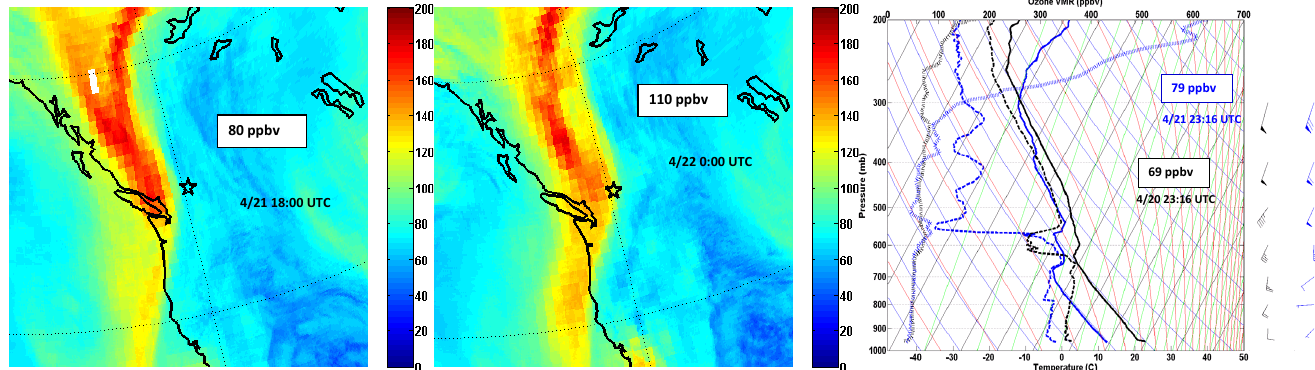
Fig. 5. MUTOP versus the Kelowna, BC ozonesonde launch on 21 April 2006. The two zoomed MUTOP images from (a) 21 April at 18:00UTC and (b) 22 April at 00:00UTC show the rapid increase of the UT ozone over six hours associated with the advancement of the dry-air streamer. The color bars represent layer-average UT ozone VMR inppbv and the black stars mark the location of Kelowna, BC, where the MUTOP estimated value is shown in the box for each time. (c) The Skew-T Log-P diagram presents vertical profiles of ozone, temperature, dewpoint temperature, and column winds for the previous day, 20 April (gray crosses, black line, black dash line and black wind barbs respectively) and the 21 April(light blue crosses, blue line, blue dash line, and blue wind barbs) ozonesonde launch; the UT ozonesonde average mixing ratio is shown in the box for each time,